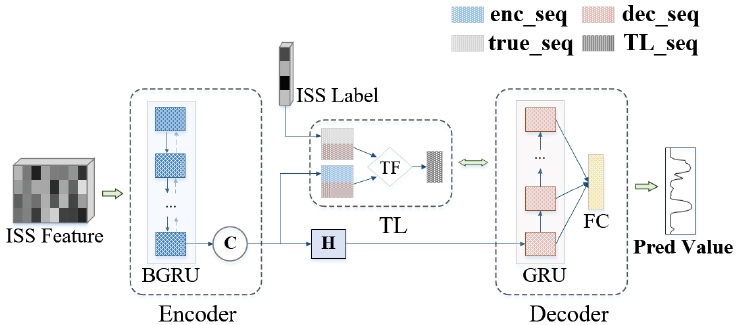
Figure 13. TL-Seq2Seq network structure.